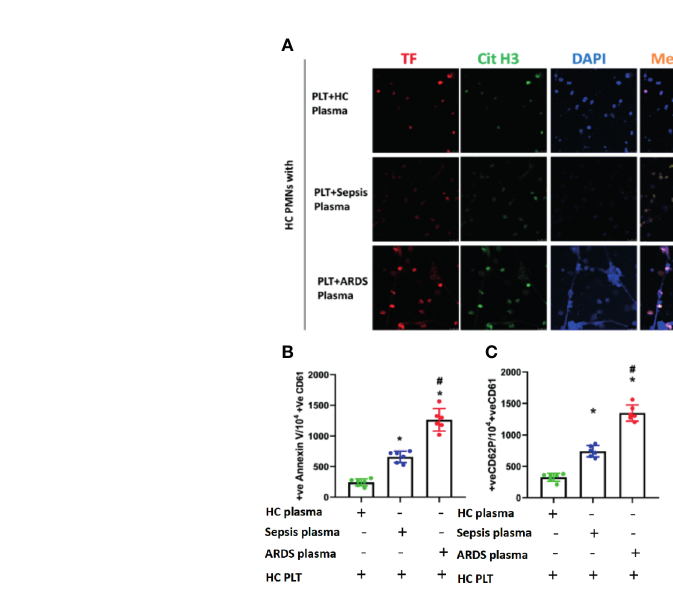
FIGURE 5 | Activated platelets for subsequent NET generation in PMNs. (A) Neutrophil extracellular trap formation by control polymorphonuclear neutrophils incubated with control platelets pretreated with plasma obtained from the 3 groups. (B) Fluorescence-activated cell sorting analysis of Annexin V on control platelets treated with plasma obtained from the 3 groups (n=6). (C) Fluorescence-activated cell sorting analysis of CD62P on control platelets treated with plasma obtained from the 3 groups (n=6). (D) Percentage of NET-releasing polymorphonuclear neutrophils of control polymorphonuclear neutrophils treated with platelets and plasma obtained from the 3 groups (n=6). P < 0.05 (*) and P < 0.05 ( # ) compared to baseline healthy controls and the sepsis group were considered statistically signi fi